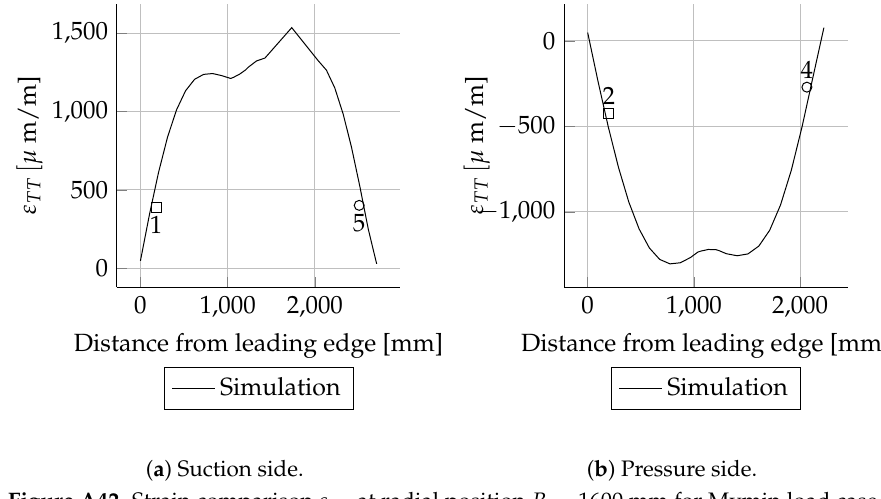
Figure A42. Strain comparison ε LL at radial position R = 1600 mm for Mymin load case.